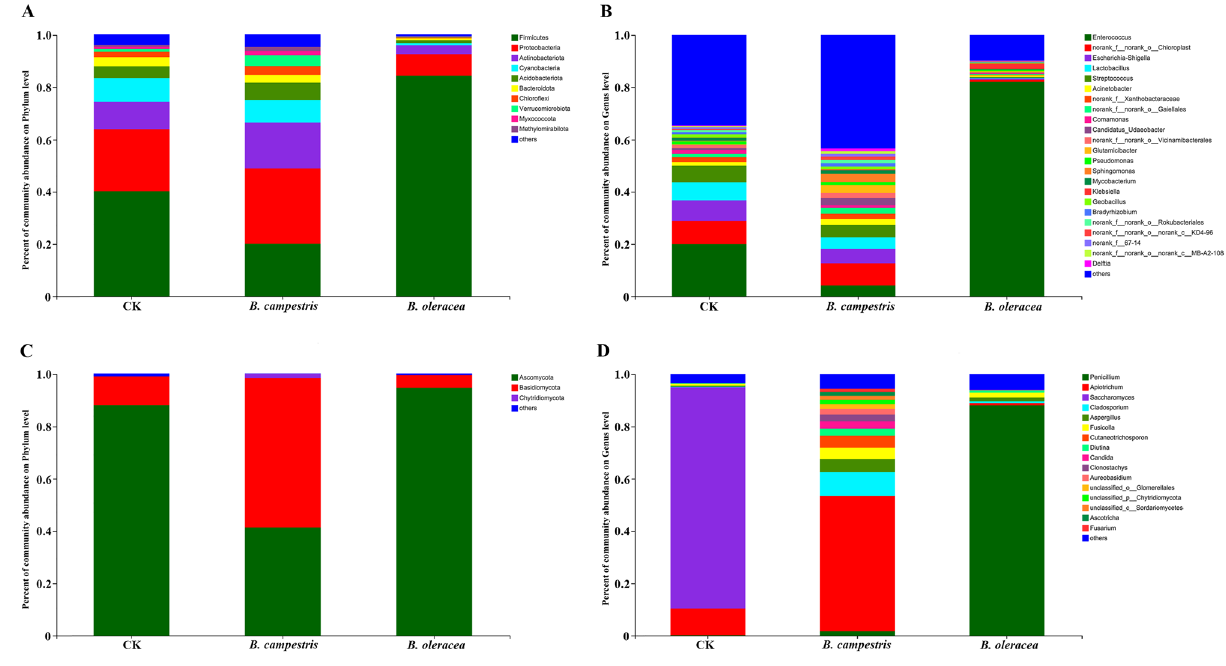
Figure 4. The microbial composition analysis in different groups of S. frugiperda larvae. ( A ) and ( B ) represent the bacterial composition in different groups at the phylum and genus levels. ( C ) and ( D ) represent the fungal composition in different groups at the phylum and genus levels. CK: the group fed on an artificial diet, B. campestris: the group fed on B. campestris; B. oleracea: the group fed on B. oleracea. The figure was created by R project Vegan package (version 2.4–3) (https:// github. com/ vegan devs/ vegan/ relea ses/ tag/